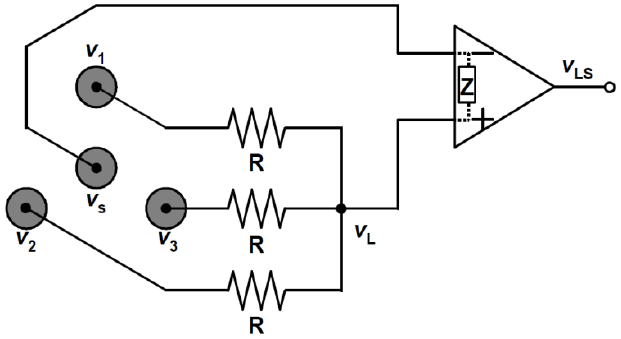
Figure 2. MacKay’s configuration of electrodes and a circuit connected to them for deriving an approximate surface Laplacian